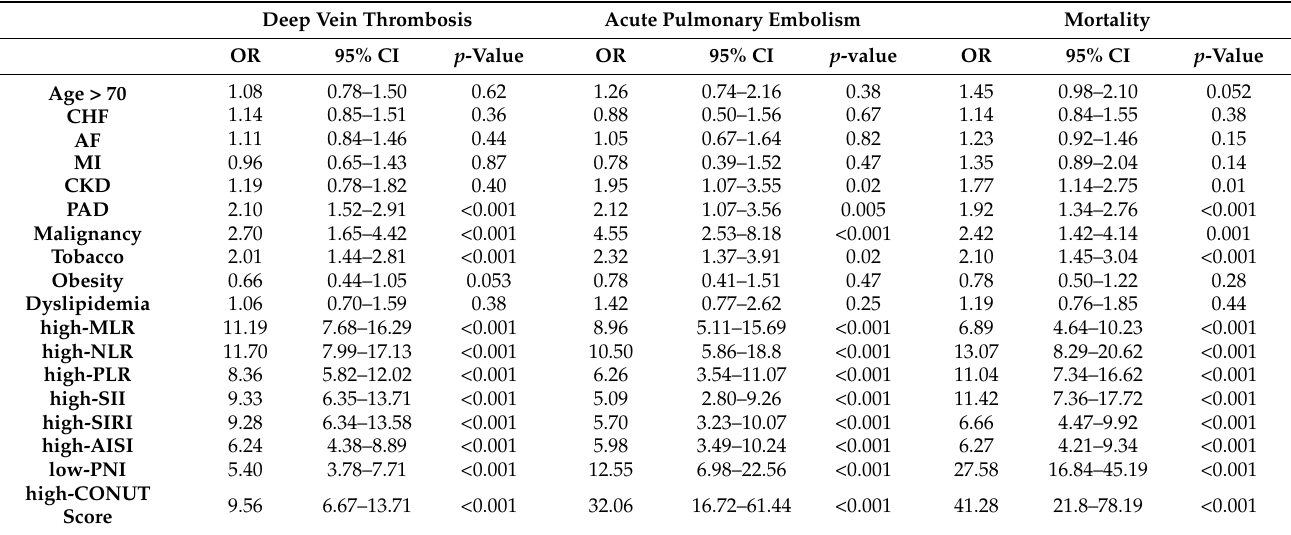
Table 5. Multivariate analysis for predictors of DVT and APE risk, and mortality during the hospital- ization